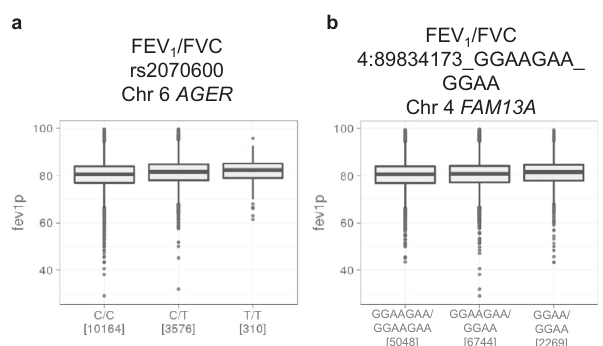
Fig. 4 The effects of genetic variants repeated at both Discovery and Validation Stage for FEV 1 /FVC. a , b The measures of FEV 1 /FVC in each genotype of the sentinel variant are shown. Boxes represent the inter- quartile range (IQR) between fi rst quartile (Q1) and third quartile (Q3), the line inside represents the median. Whiskers denote the lowest and highest values within 1.5 × IQR from the Q1 and Q3 respectively. Black dots represent outliers beyond the whiskers. FEV 1 forced expiratory volume in one second, FVC forced vital